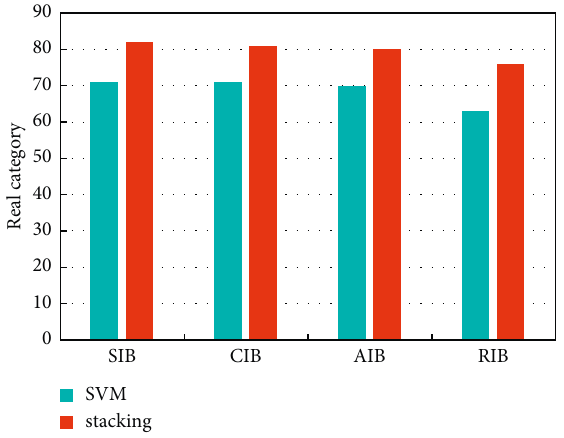
Figure 9: Comparison of four kinds of integral bispectrum in stacking versus